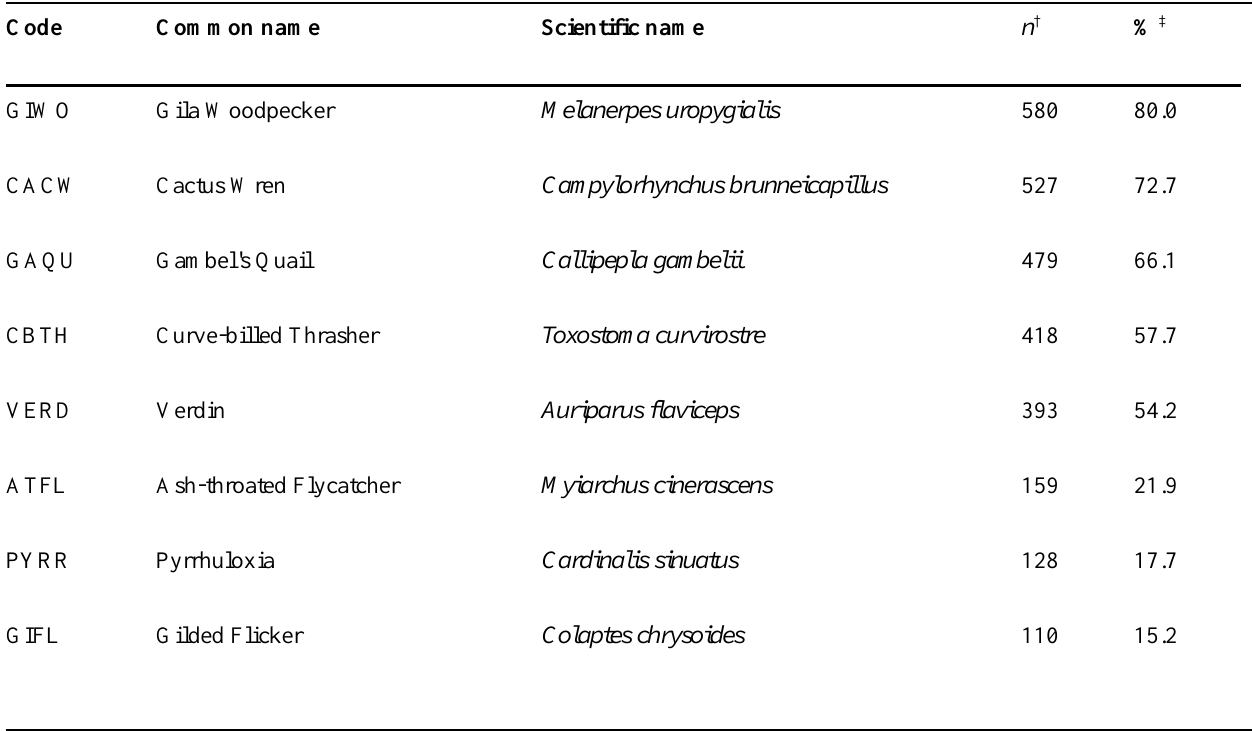
Table 1. Desertscrub study species and overall frequency of occurrence in Tucson Bird Count data. † Number of sites at which species recorded. ‡ Percent of 725 total sites at which species